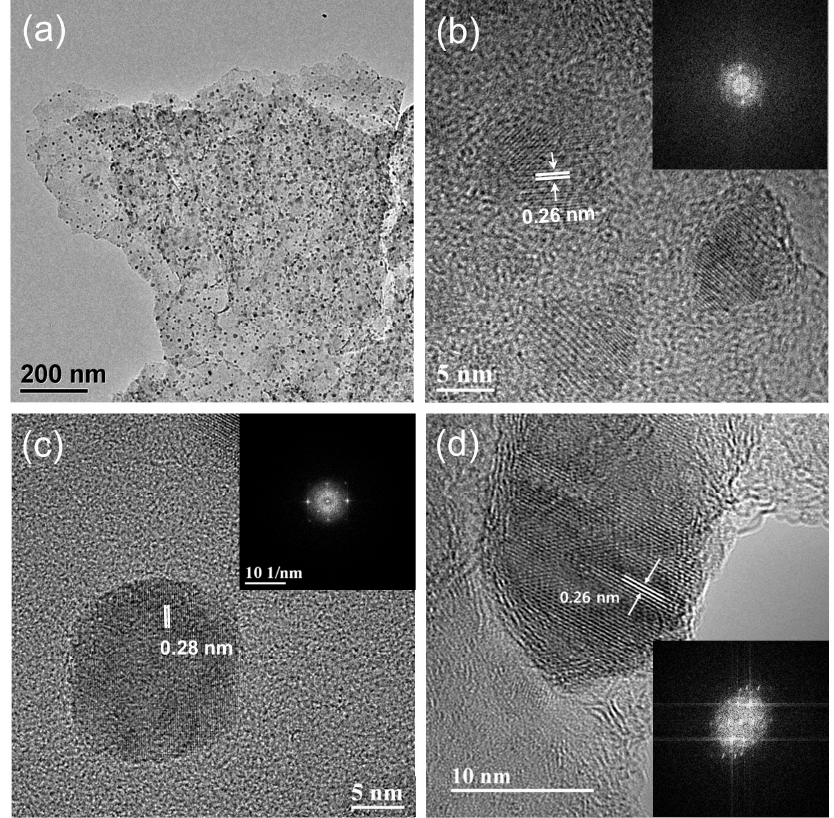
Figure 2. ( a ) A typical transmission electron microscopy (TEM) image of GM 500 , and the enlarged TEM images which reveal the structures of ( b ) MnO, ( c ) Mn 3 O 4 , and ( d ) Mn 2 O 3 .